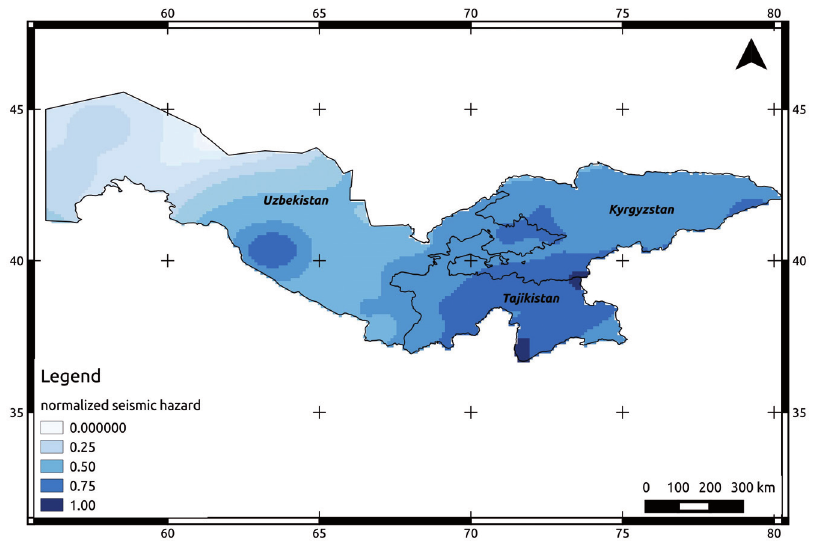
Figure 10. Normalized distribution of seismic hazard in the considered region. The input layer is defined as of macroseismic intensity (MSK- 64) with exceedance probability of 10% in 50 years.